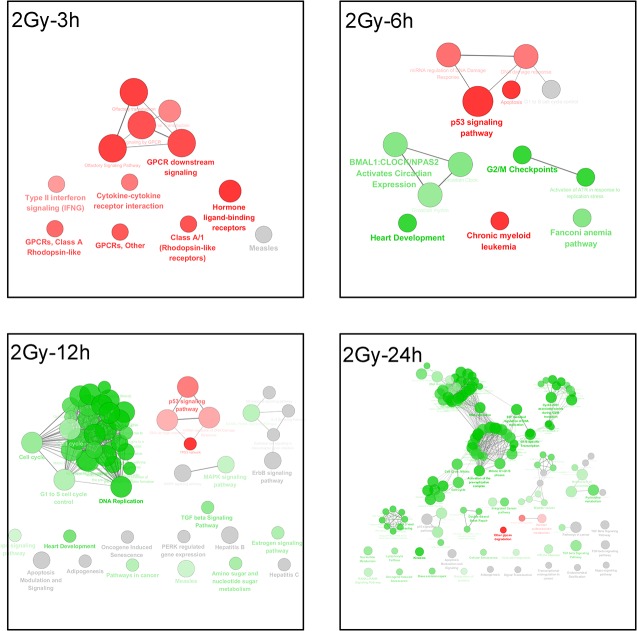
The pathway enrichment analysis results of the 2 Gy group at different time points.The KEGG, REACTOME and WikiPathways databases in ClueGO were employed for pathway enrichment analysis of each differential group gene sets acquired from microarray analyses. The Enrichment/Depletion was tested by the two-side hypergeometric test, and the Benjamini and Hochberg false-discovery rate was set to 0.05. The green and red colors code for down-regulation and up-regulation of genes, respectively, in each group.